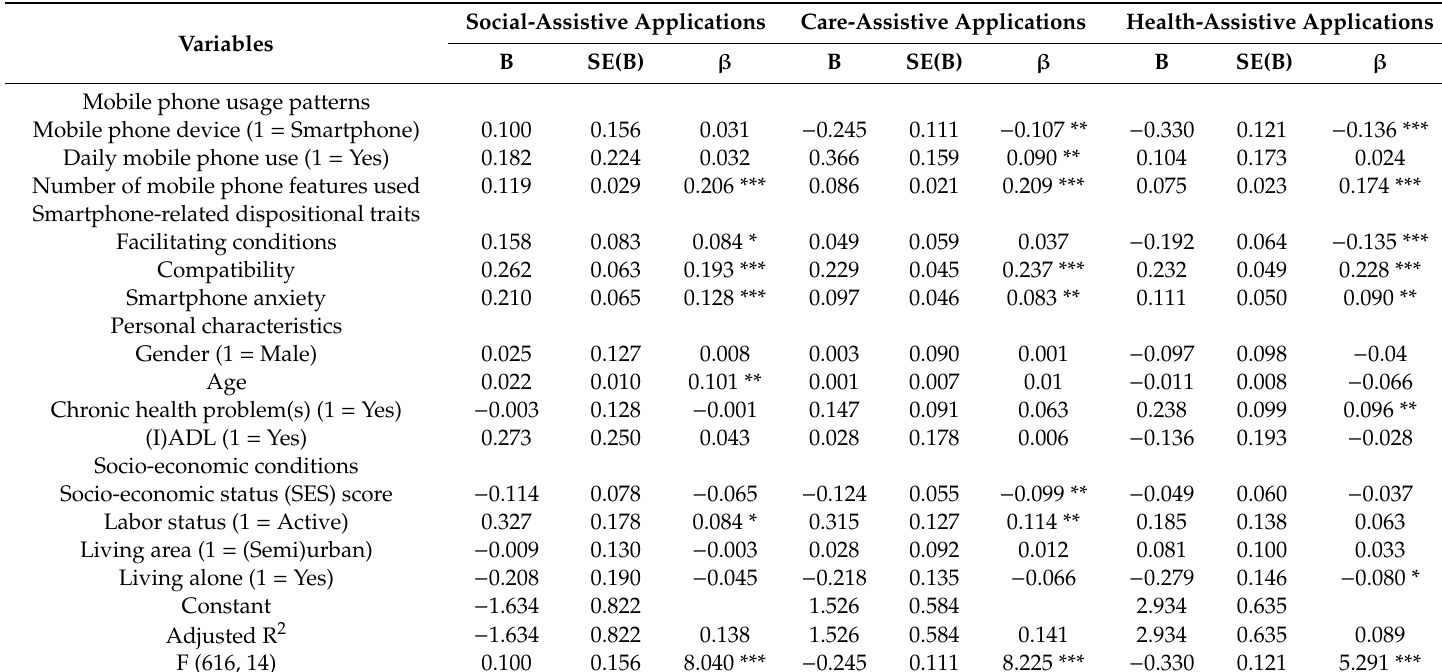
Table 4. Multiple linear regression models predicting seniors’ interest in assistive